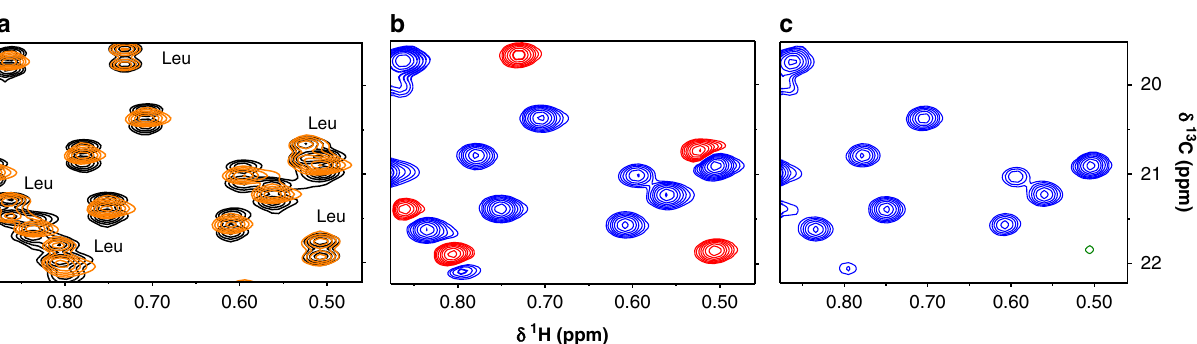
Fig. 2 Testing the selective decoupling pulse using real time and constant-time 1 H – 13 C HMQC on MBP. a Overlay of a section of a real-time 2D 1 H – 13 C methyl HMQC experiment with (orange) and without (black) the selective decoupling pulse on a 500 µ M MBP (42.5 kDa) protein. The leucine peaks remain as doublets, whereas the valine peaks collapse into singlets. b Constant-time 1 H – 13 C HMQC experiment with indirect constant-time period set to T = 28 ms (1 / 1 J T/ 2. Valine resonances are positive (blue) whereas leucine peaks are negative (red). c A version of the CC ) and shaped pulse applied at time experiment with constant-time evolution period is set to T = 42 ms (3 / (2 1 J CC )) completely eliminates the leucine peaks from the spectrum with positive valine peaks remaining (blue). Full spectra are in Supplementary